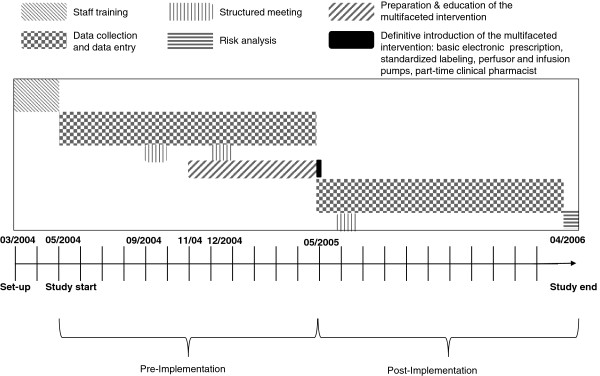
Study design. Staff training in adverse events (AE) reporting during 2 months before the pre-implementation period (May 1, 2004 to April 30, 2005). The multifaceted intervention on drug-related AEs was arranged 6 months before its definitive introduction into clinical practice (May 1, 2005). The three structured meetings with the caring staff took place during the same week in the four ICUs.